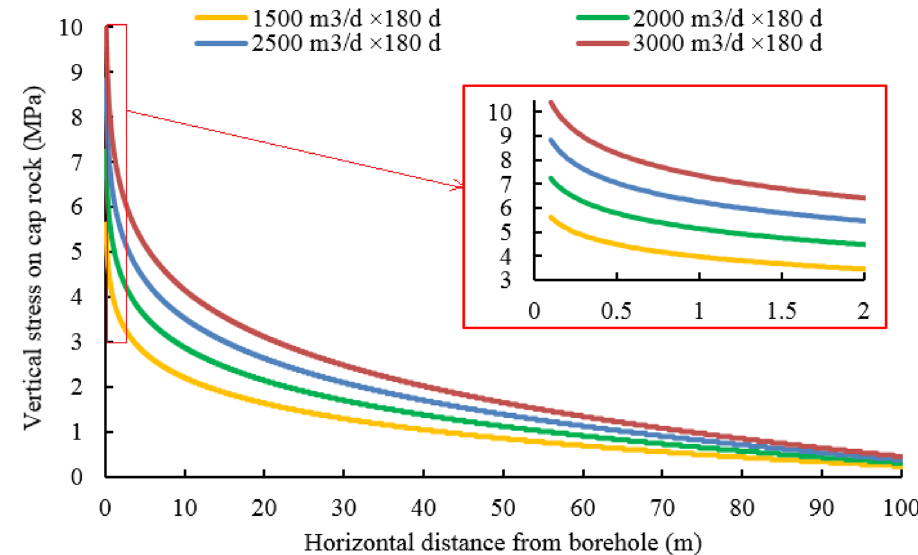
Fig. 4 Vertical stress formed by the swelling of CO 2 injection at the interface between coal and caprock interface under various injection rates